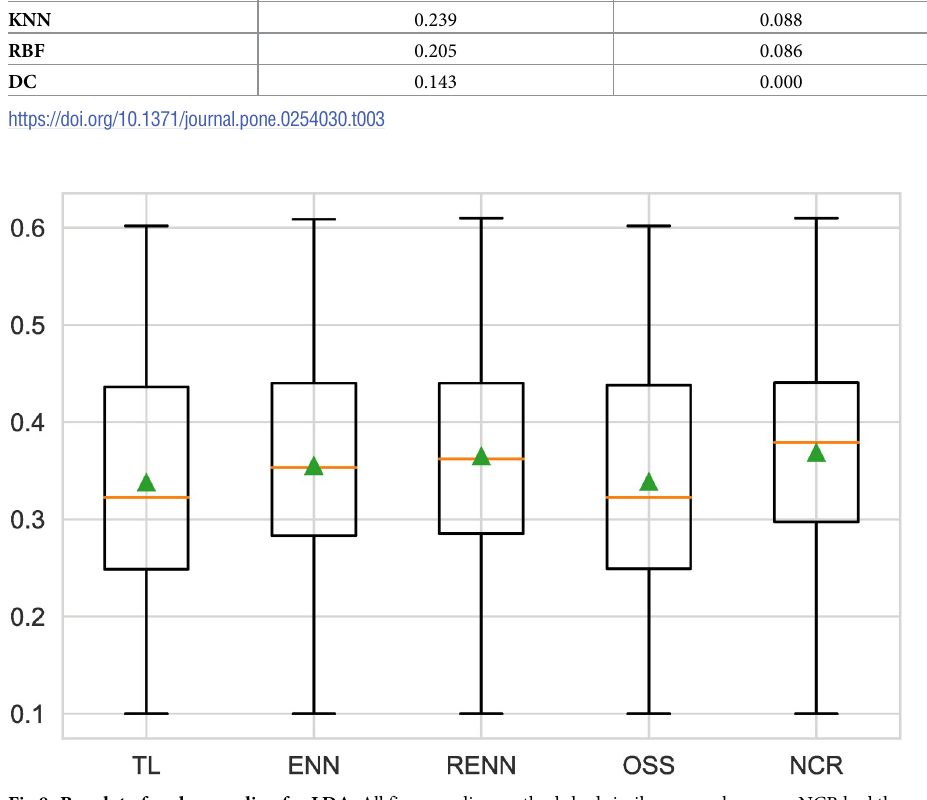
Fig 8. Boxplot of undersampling for LDA. All five sampling methods had similar scores; however, NCR had the lowest standard deviation.